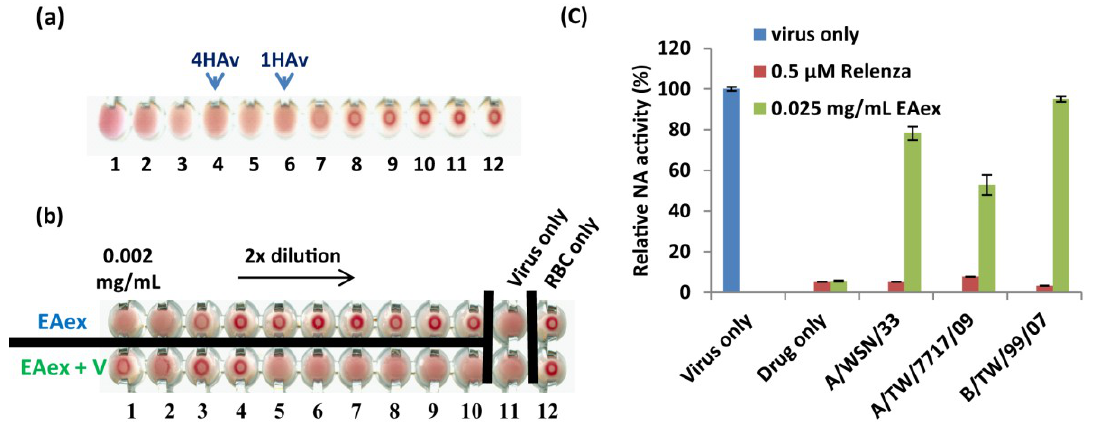
Figure 4. Effect of EAex on the HA and NA activities of influenza virus